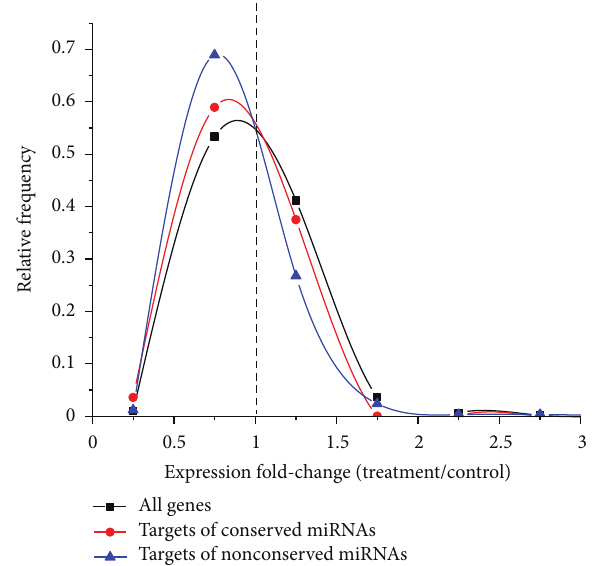
Figure 5: Relative expression levels of cassava genes after exposure to drought-like conditions. Data is from the study by Utsumi et al. [54]. Targets of conserved and nonconserved miRNA candidates display lower expression, on average, compared to all measured cassava genes upon stress